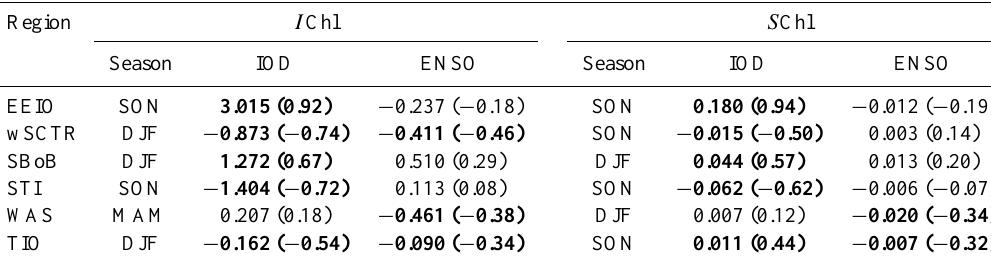
Table 2. Partial regression coefficients (and partial correlation coefficients in brackets) of I Chl (mgm − 2 ) and S Chl (mgm − 3 ) anomalies versus the relevant climate index (DMI and Niño3.4). The season selected is that in which the multiple regression including DMI+Niño3.4 explained the greatest proportion of I Chl or S Chl variance (which is quoted in Table 3). Bold figures denote significant regression or correlation coefficients ( p < 0 . 05).